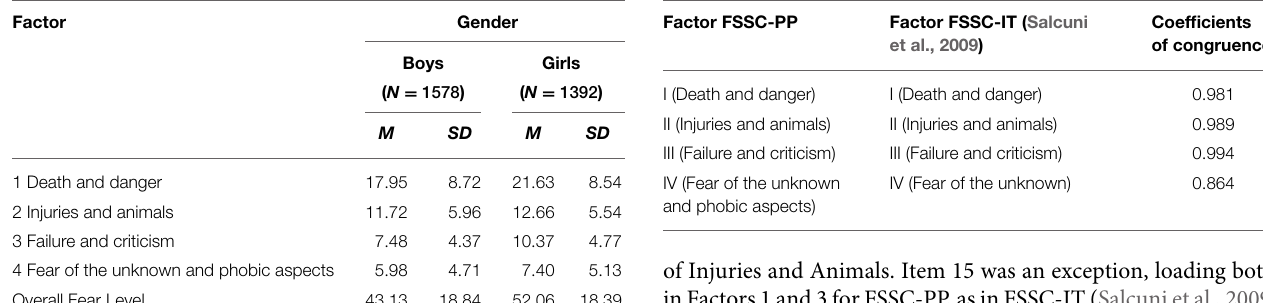
TABLE 5 | Coefficient of congruence values comparing the FSSC-PP and the FSSC-IT. Factor FSSC-PP Factor FSSC-IT (Salcuni et al.,